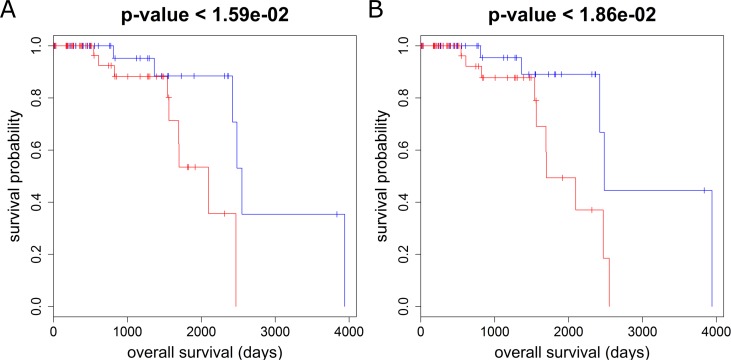
Kaplan-Meier plots of subgroups separated by median expressions of two hub genes AQP7 (A) and CIDEC (B), showing significant logrank p-values.Blue curves showing lower risks correspond to lower expressions, and red curves showing higher risks correspond to higher expressions.